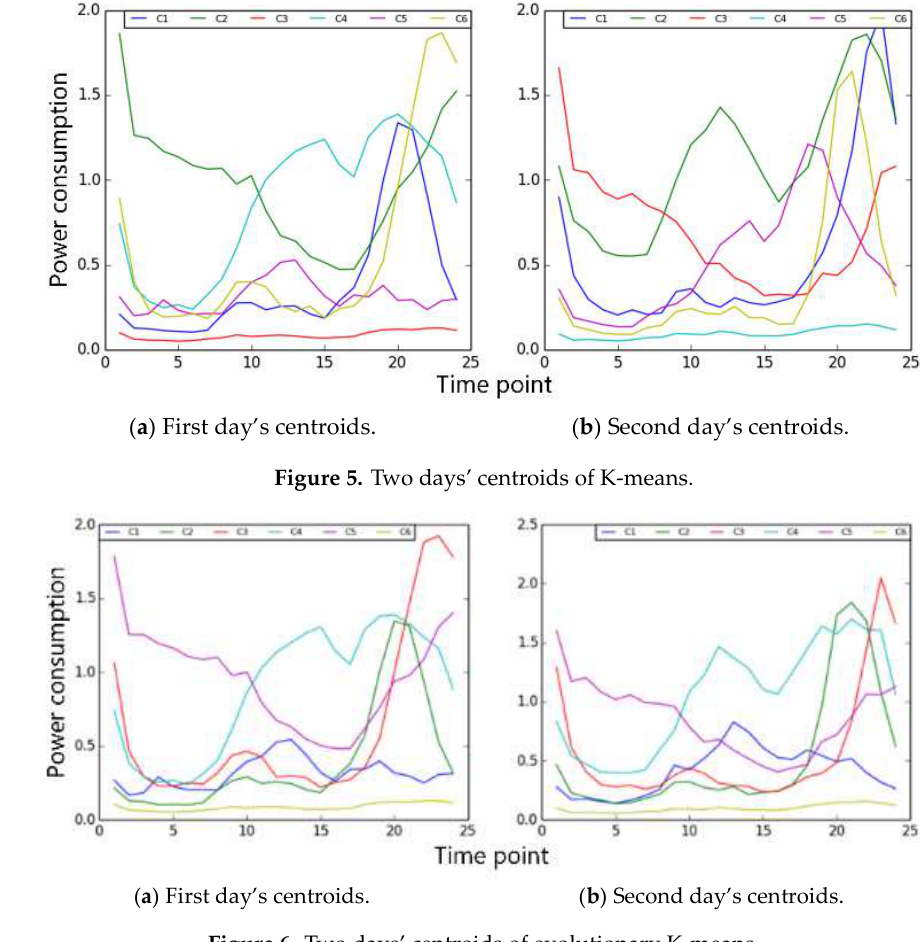
Figure 6. Two days’ centroids of evolutionary K-means.